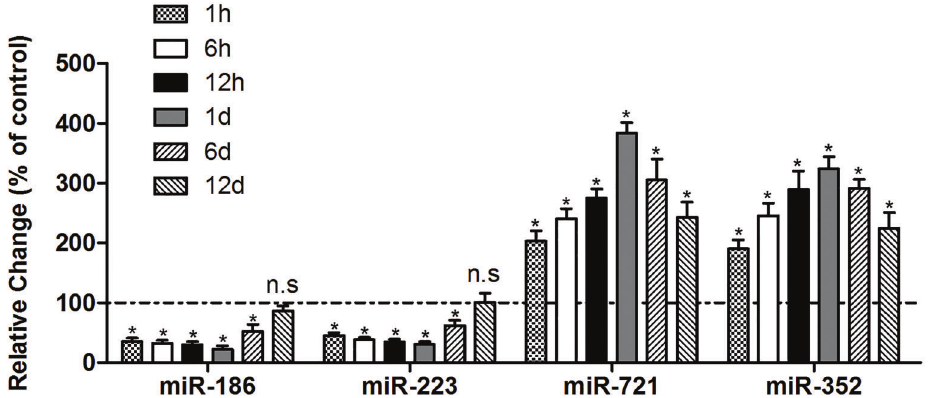
Figure 5. Dysregulated miRs found in trigeminal ganglions from complete Freund ’ s adjuvant (CFA)-injected mice assessed by RT-qPCR at each time-point (n=6). Data are reported as means ± SD. *P o 0.05 vs control group (ANOVA followed by a post hoc Tukey ’ s test). n.s.: not signi fi cant.